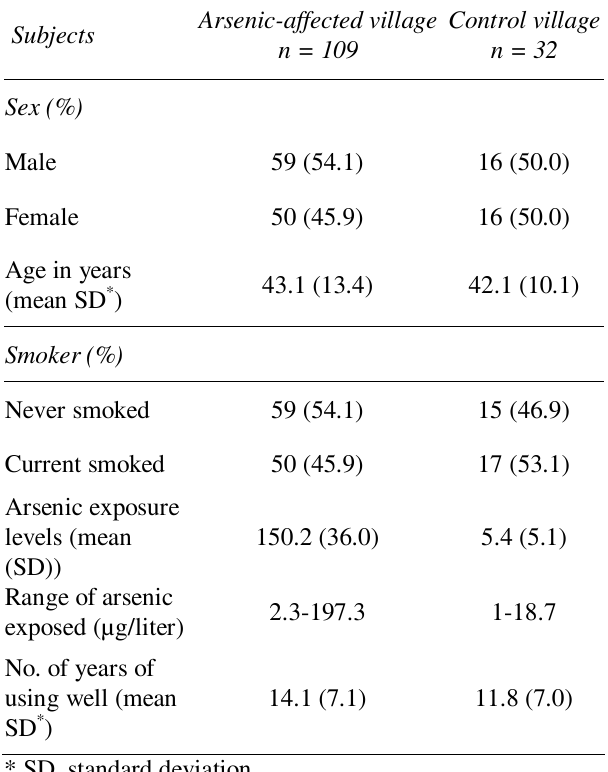
Table 1: The characteristics of the subjects in the present study.